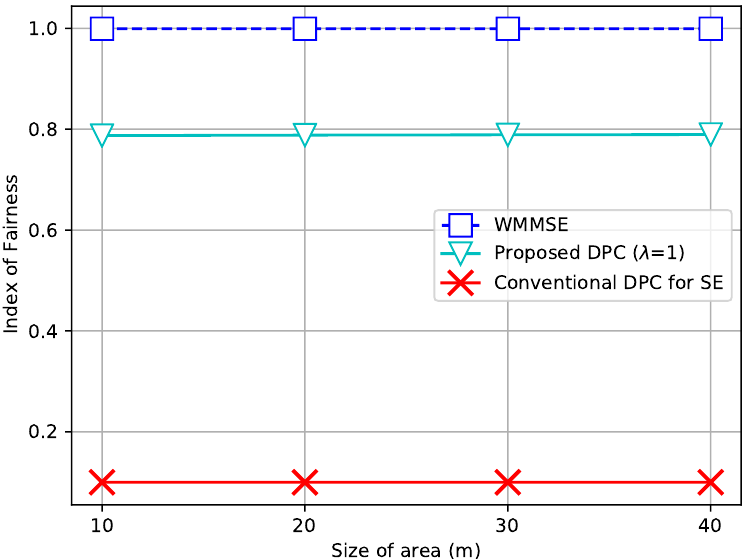
Figure 5. Index of fairness of the conventional schemes and the proposed scheme for various area sizes in Rayleigh fading